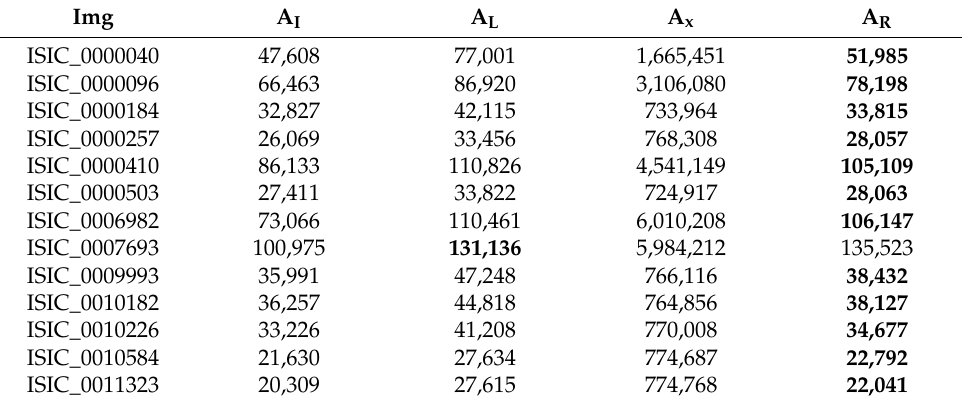
Table 6. Average hair area values on the HSim-data to compare with < AI > = 42648—best results are in bold.